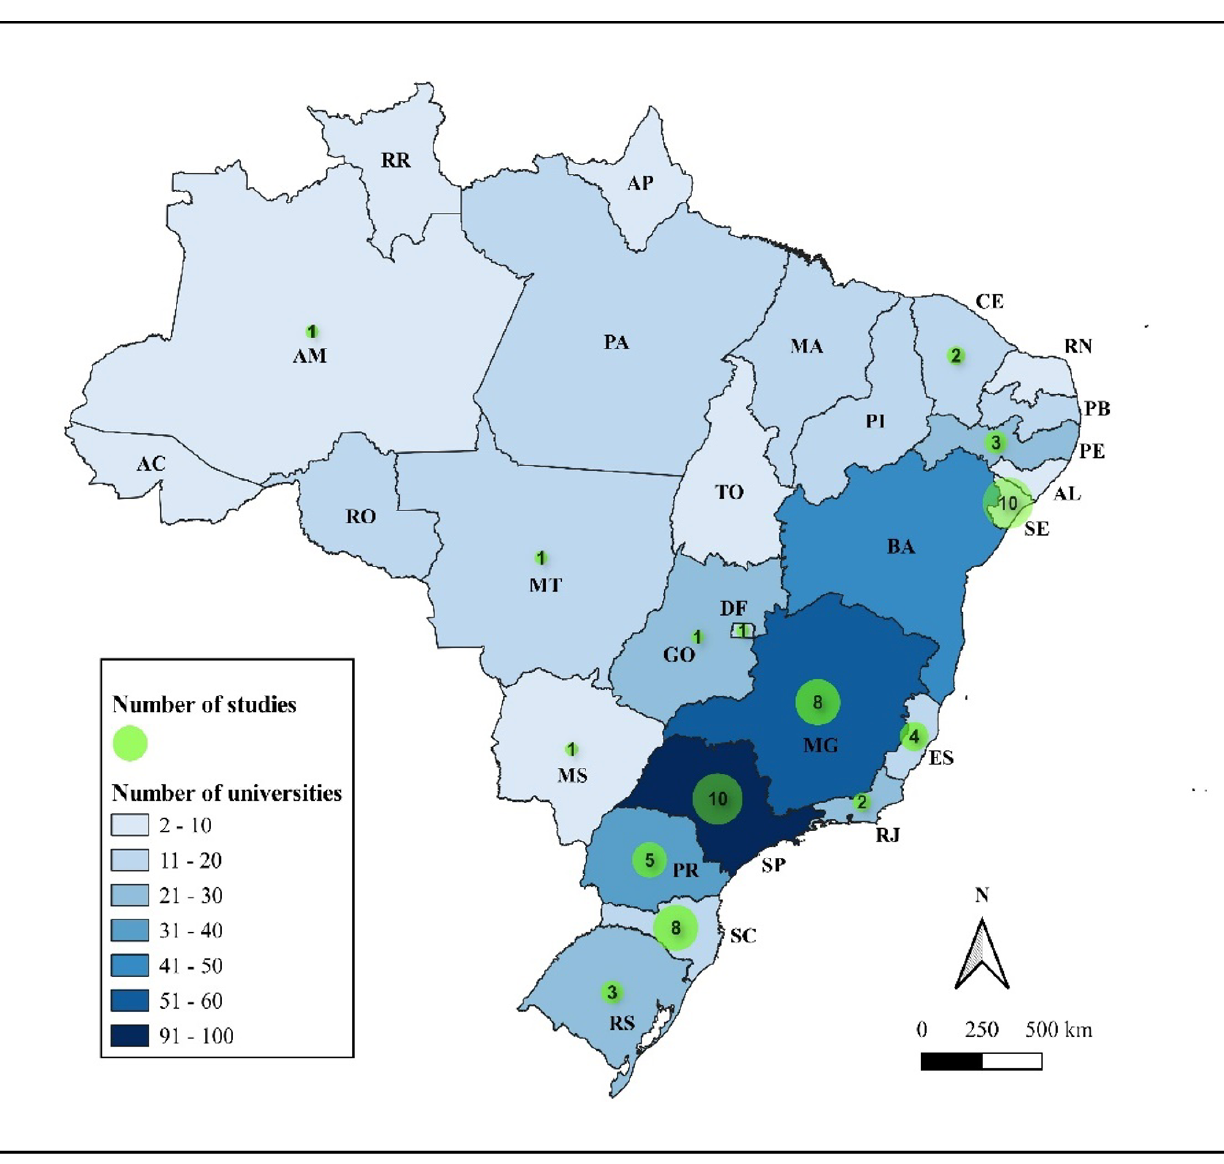
FIGURE 2 - Geographic distribution of the studies and number of universities with pharmacy courses by